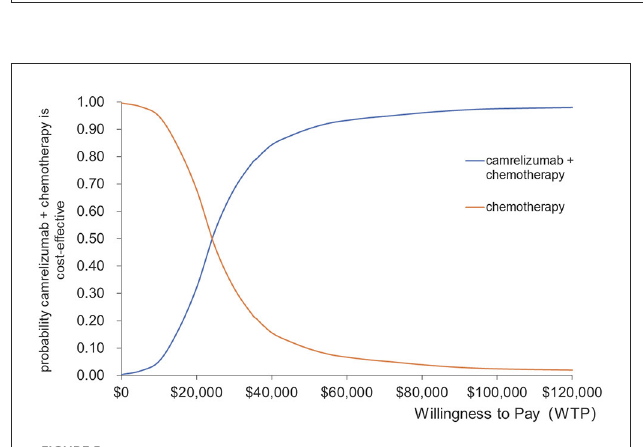
FIGURE5 Cost-effectiveness acceptability curve for camrelizumab + chemotherapy vs. chemotherapy.